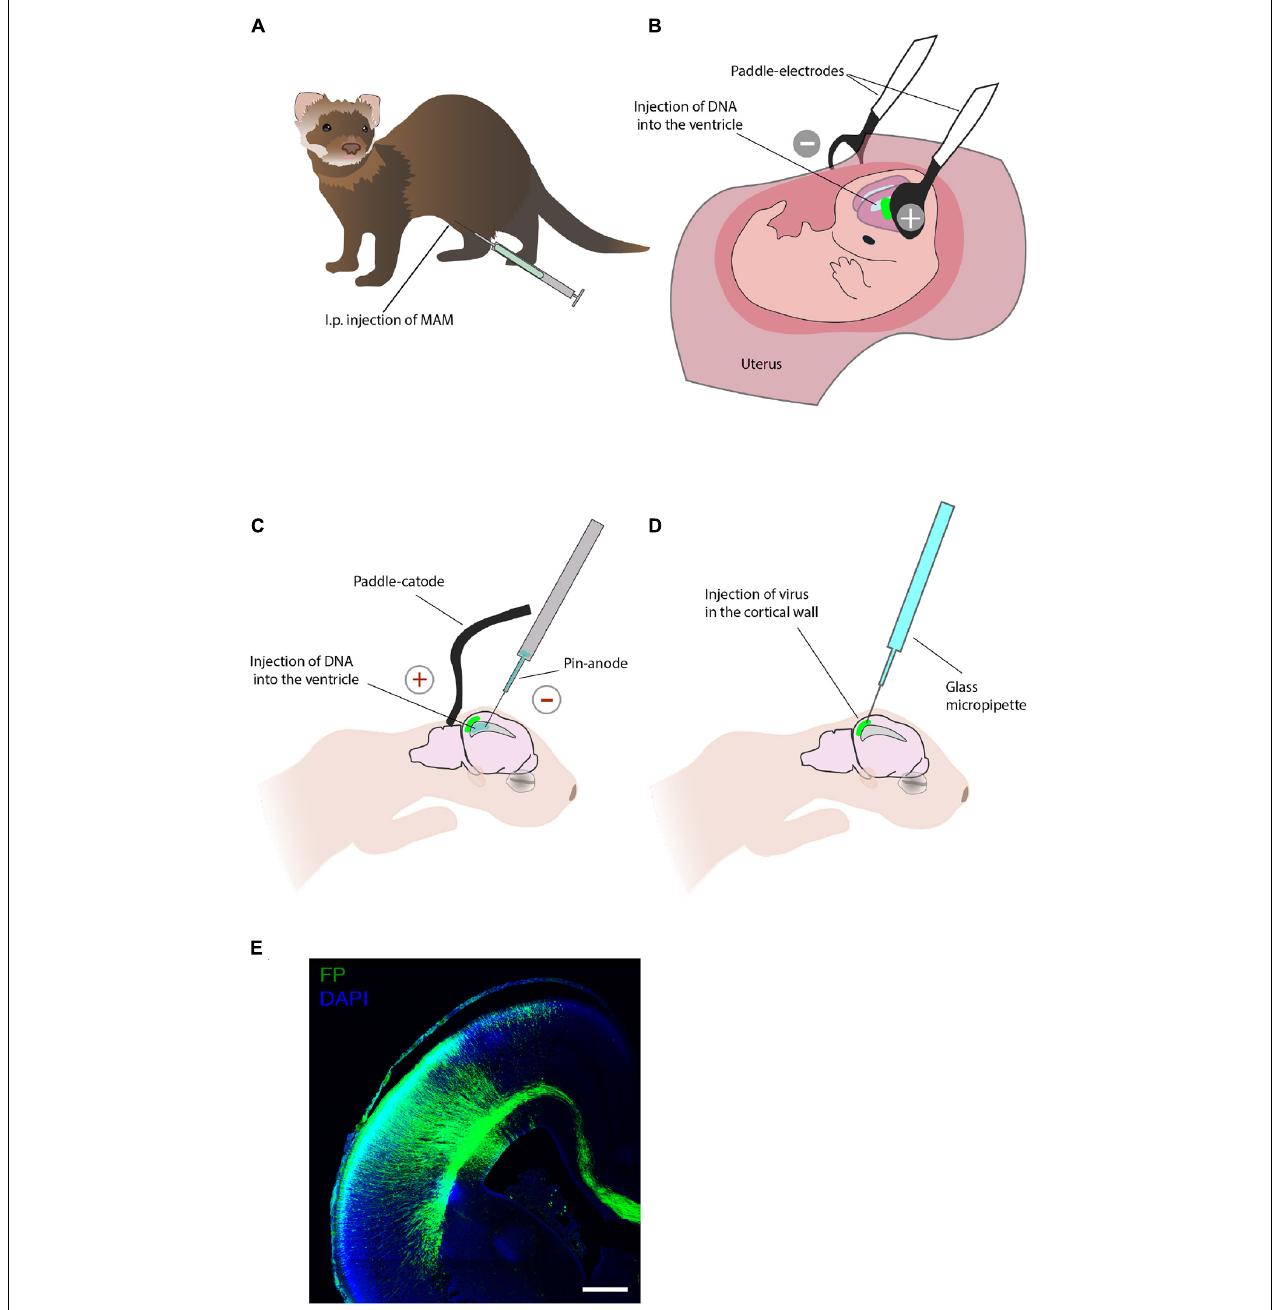
FIGURE 3 | Techniques that allow acute manipulation of the ferret neocortex development in vivo. (A) Pharmacological treatment. Intraperitoneal (i.p.) injection of the anti-mitotic drug methylazoxymethanol (MAM) allows to study neurogenesis and model cortical dysplasia. (B) In utero electroporation enables manipulation of gene expression in neural progenitors and their progeny during embryonic development. (C) Postnatal electroporation during the first week of postnatal life enables studies of neuronal migration. (D) Viral injection at postnatal stages applied to study neural migration. (E) An example of the ferret P0 neocortex that was targeted by in utero electroporation at E33. Immunofluorescence for GFP (green), combined with DAPI staining (blue). Scale bar, 500 µ m. This image has been modified from Kalebic et al.